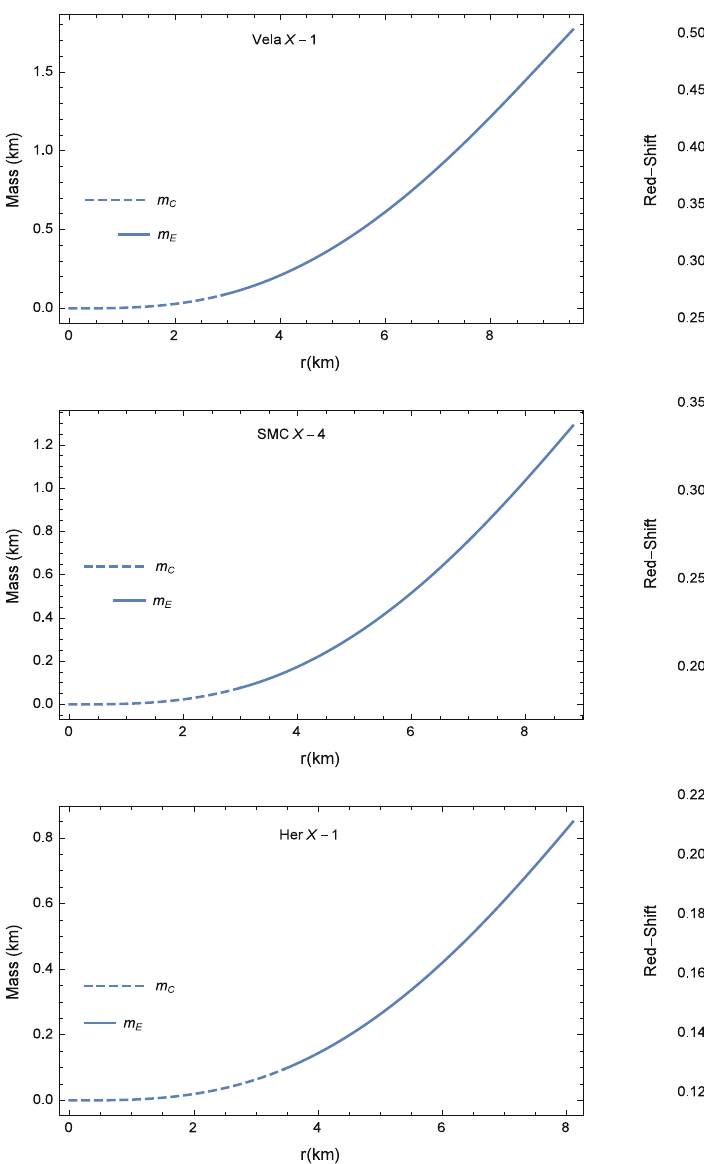
Fig. 6 Variation of red-shift with radial coordinate r for (i) the neutron star in Vela X-1(upper) (ii) SMC X-4 (middle) (iii) Her X-1